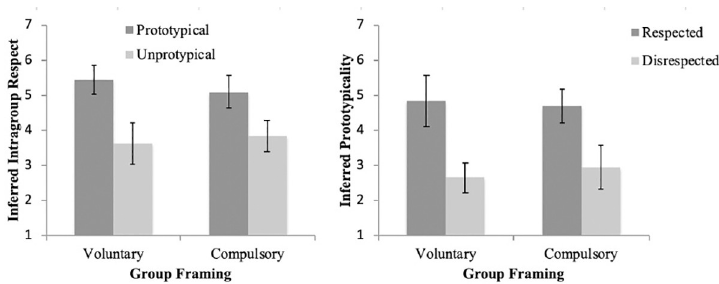
Fig 2. Inferred intragroup respect and inferred prototypicality as a function of target prototypicality and target intragroup respect.